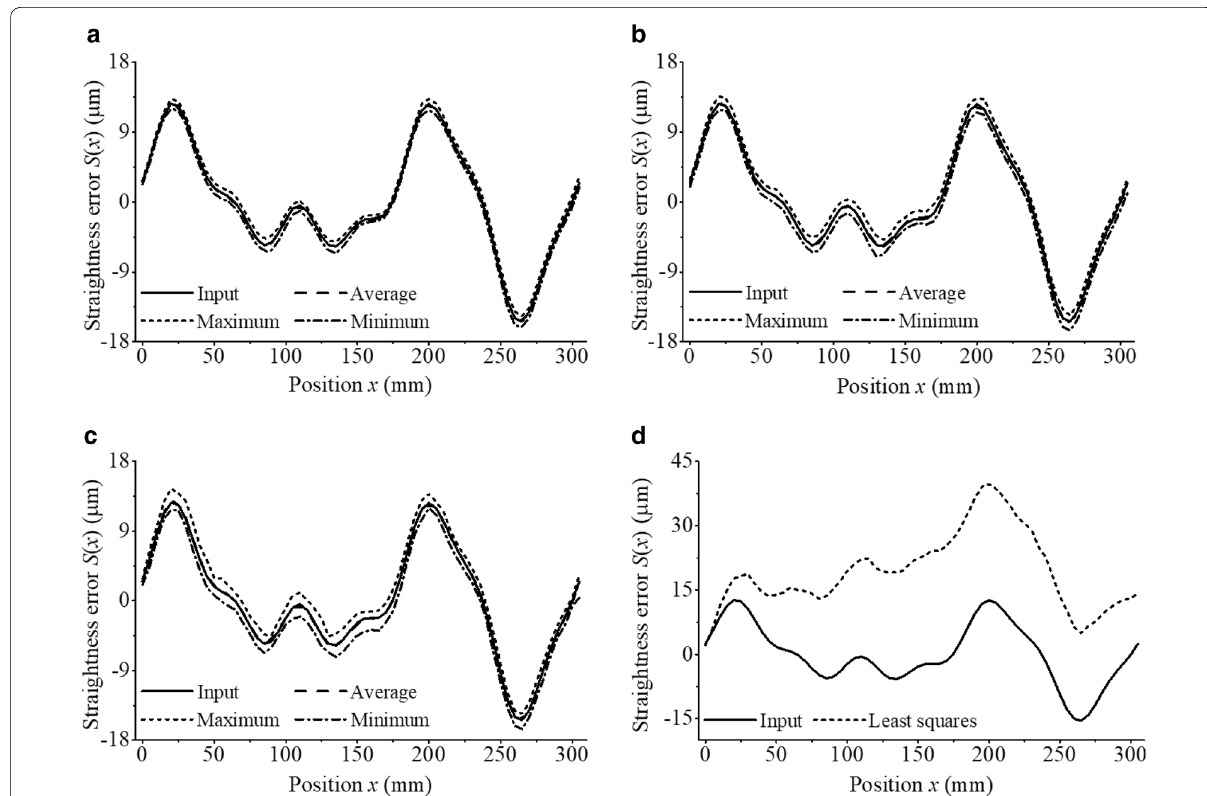
Figure 3 Simulation results related to S ( x ): average curve, maximum curve, minimum curve and input curve as a σ σ 0.3 μm, d least squares curve and input curve as σ =